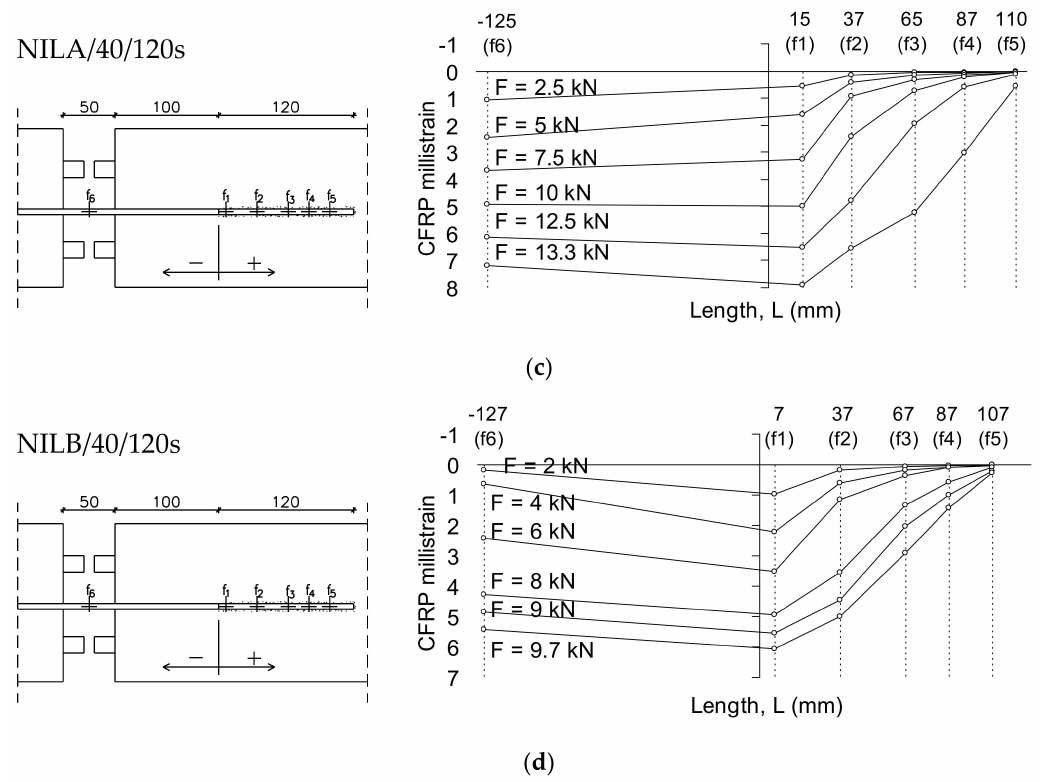
Figure 6. Experimental CFRP strain profiles for beams: ( a ) NILA/40/100, ( b ) NILB/40/120, ( c ) NILA/40/120s and ( d ) NILB/40/120s